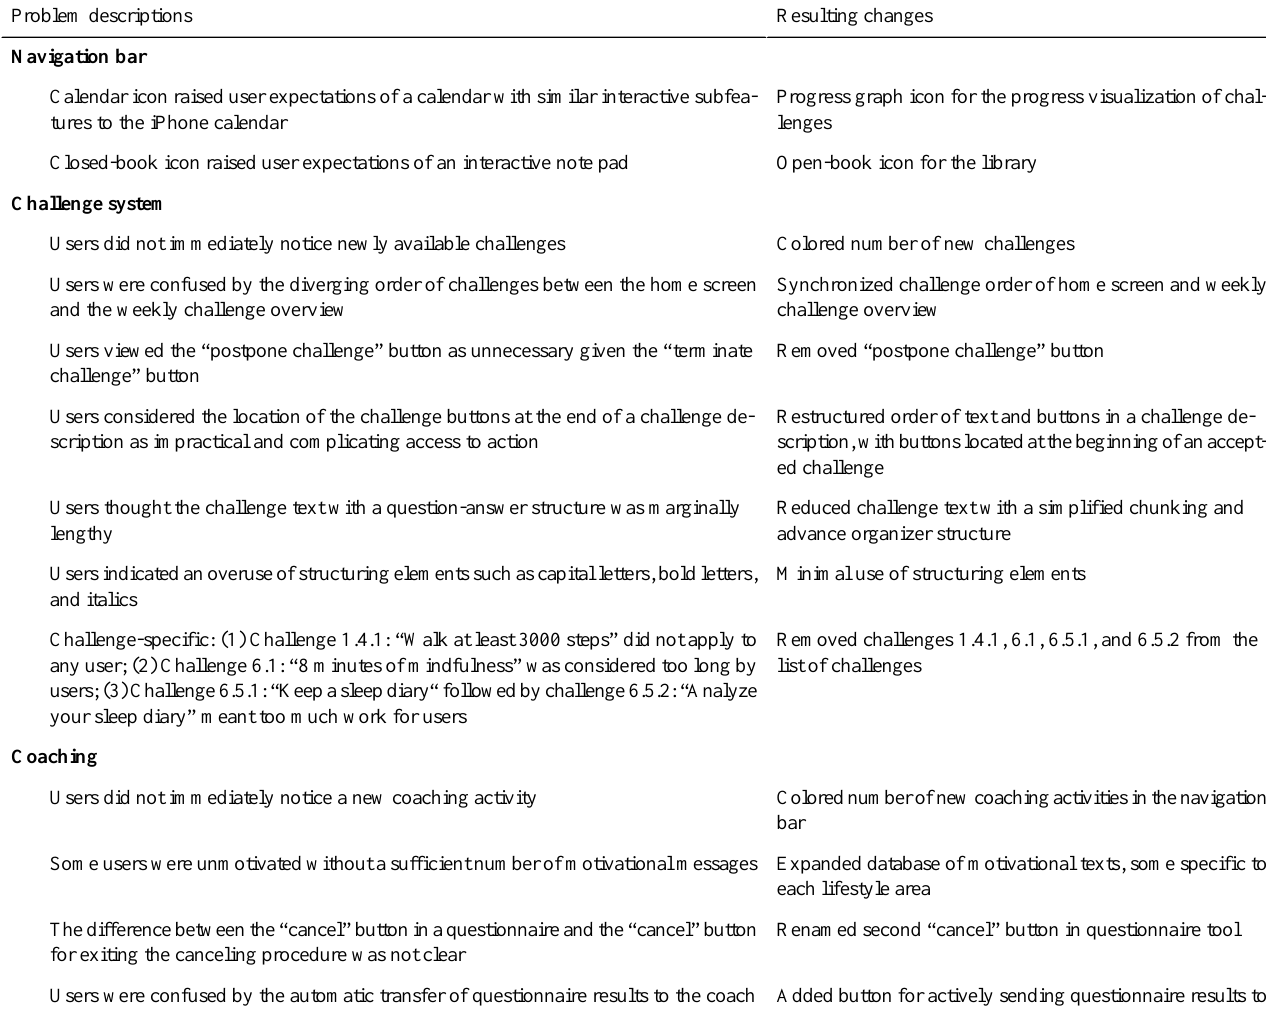
Table 5. Exemplary problem descriptions and resulting changes to the TRIANGLE app after the TRIANGLE user